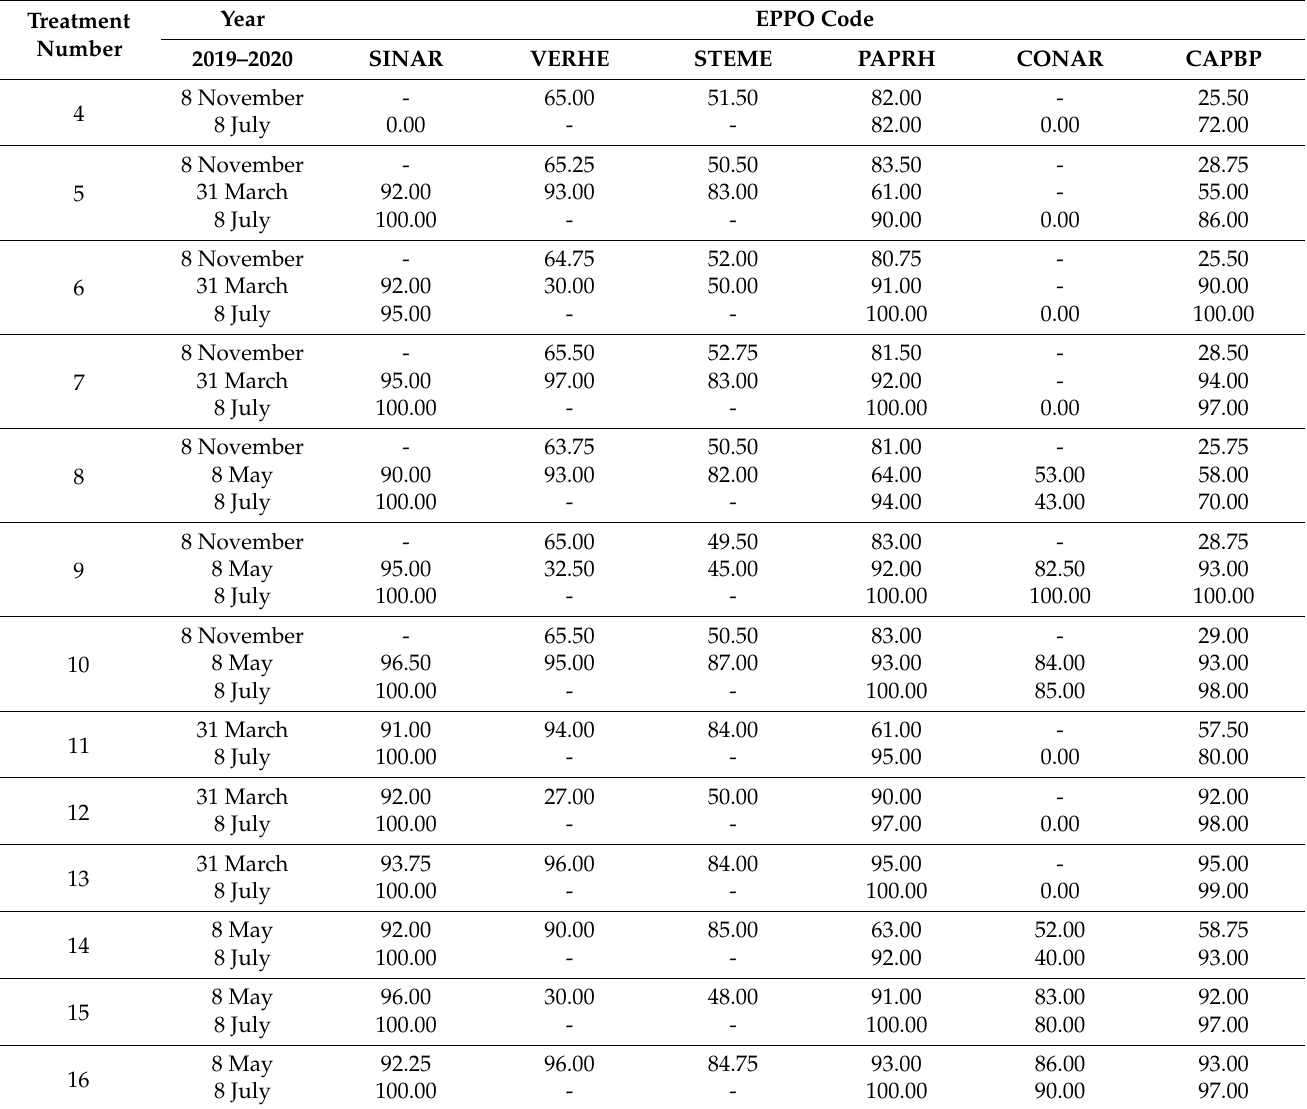
Table 8. Weed control efficiency of chemical treatments compared to weed cover of untreated